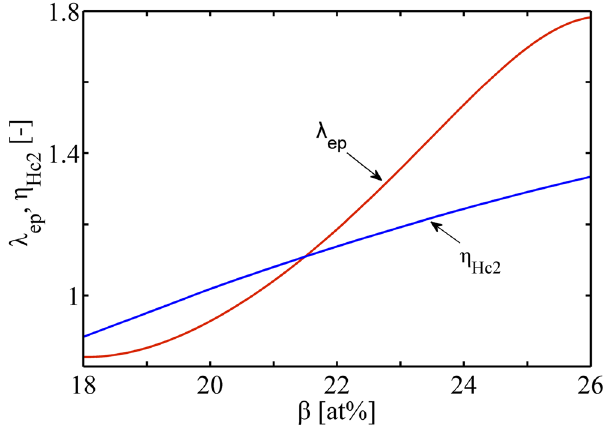
Figure 3. EP correction parameters, the Debye temperature θ D and energy gap Δ (0), versus tin